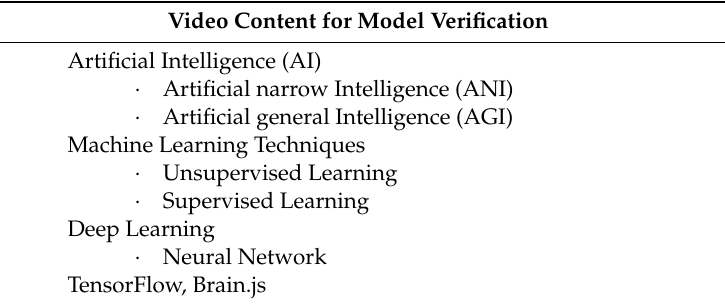
Table 4. Video content design used for model validation.